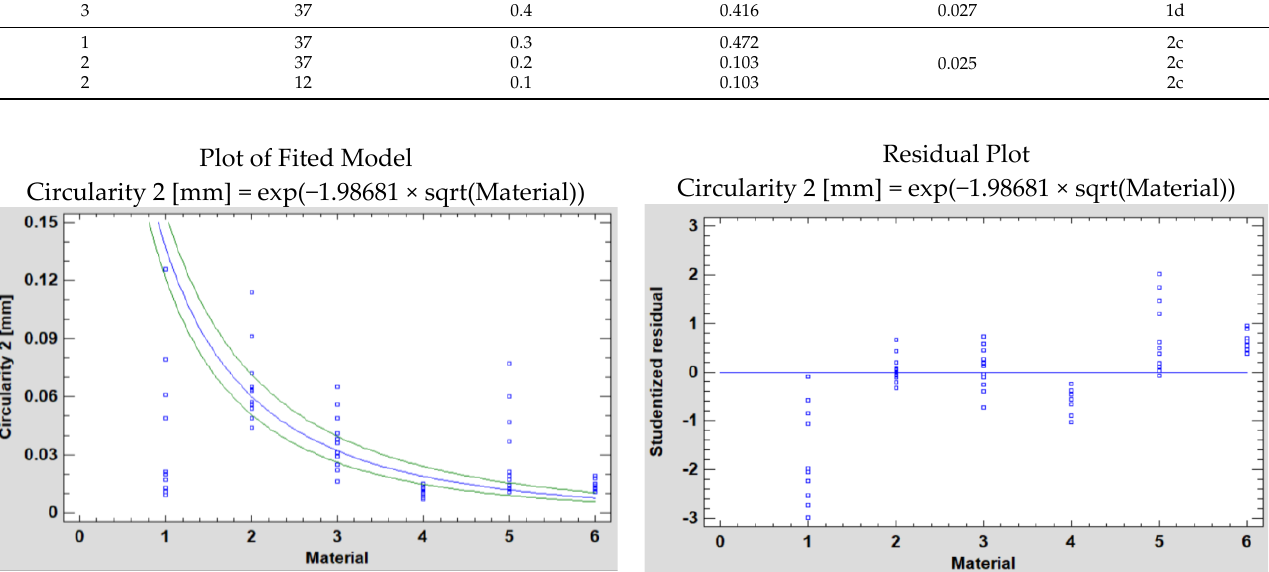
Table 4. Comparison of Alternative Models.